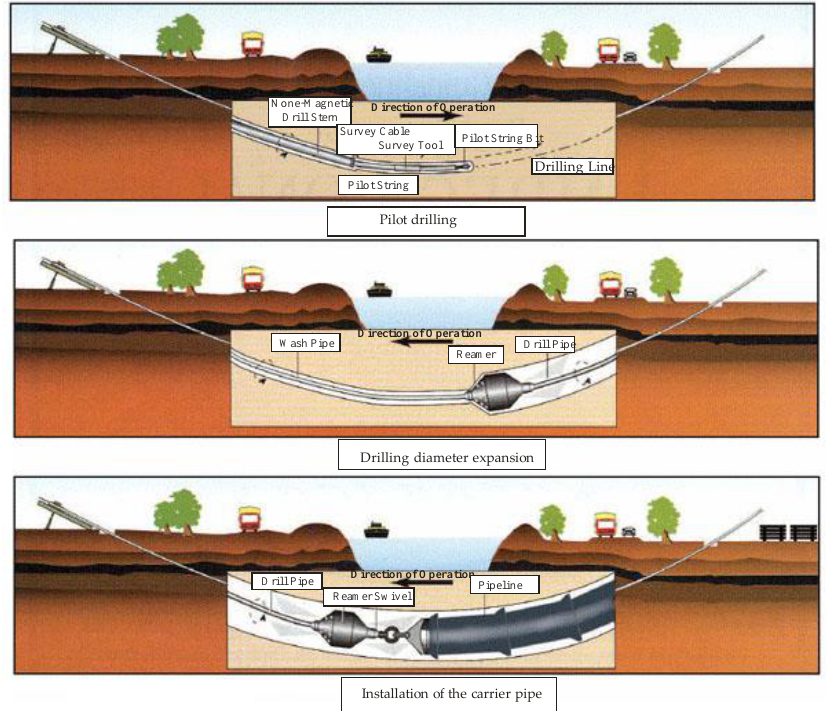
Figure 3. Stages of horizontal directional drilling (HDD). Source: HD Drilling Contractors-changed [34].